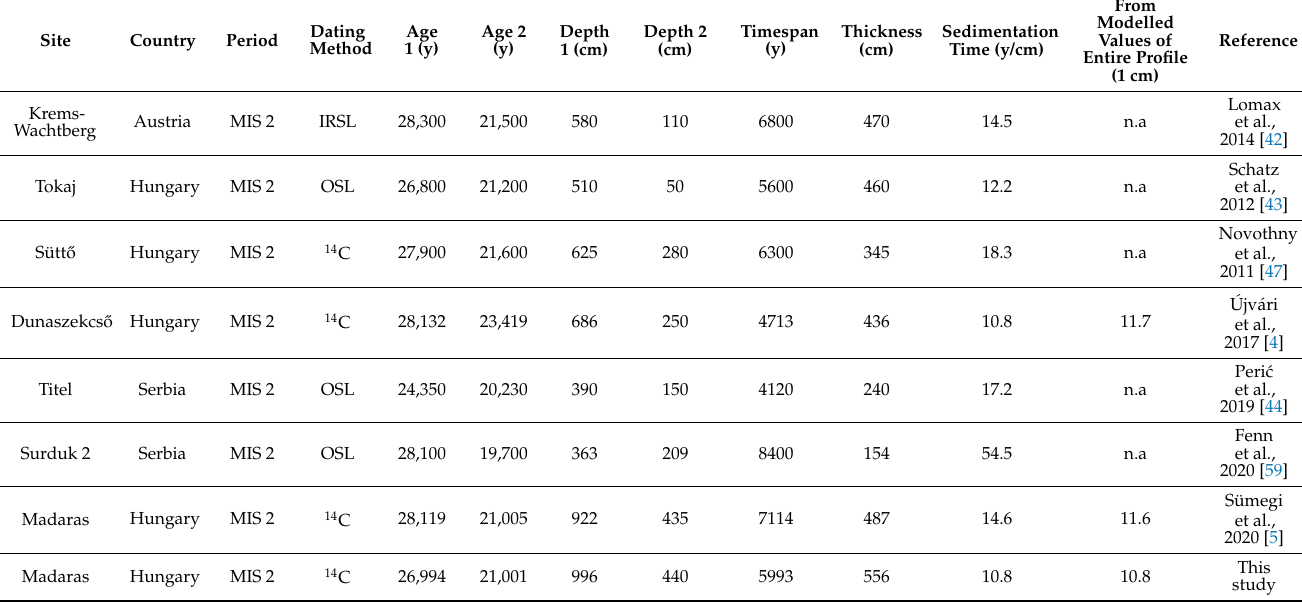
Table 4. Comparison of sedimentation times for various MIS 2 Carpathian Basin